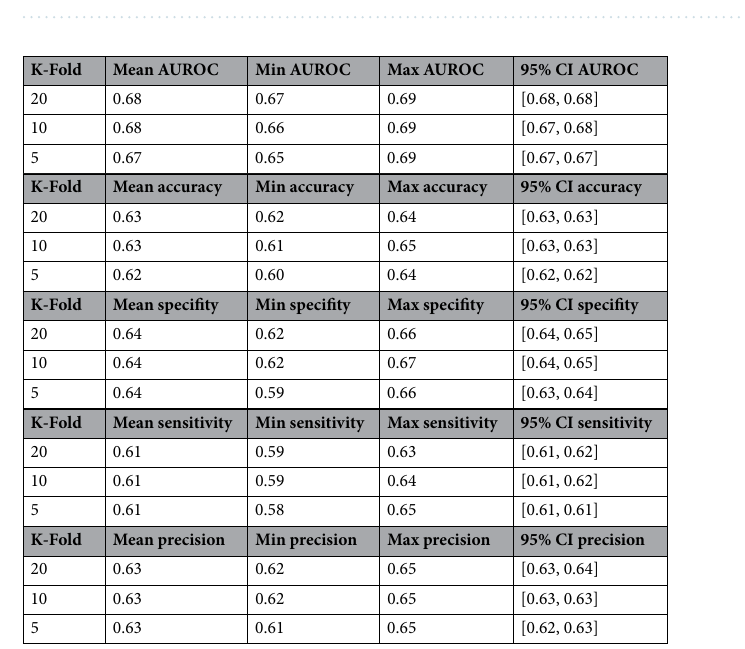
Figure 4. Mean AUROC and mean accuracy values against the latent variables in case of the fingerprint region (1800–900 cm −1 ) and region of 1490–1180 cm −1 . Results from ( a ) k-fold 20, ( b ) k-fold 10 and ( c ) k-fold 5 have been presented. As seen from the figure, 32 latent variables yielded the best performance when fingerprint region was studied, and k-fold was 20 or 10, but for k-fold 5 the 31 latent variables were the best possible choice. In case of region of 1490–1180 cm −1 , the 13 latent variables showed the best performance for k-folds 20, 10 and 5.